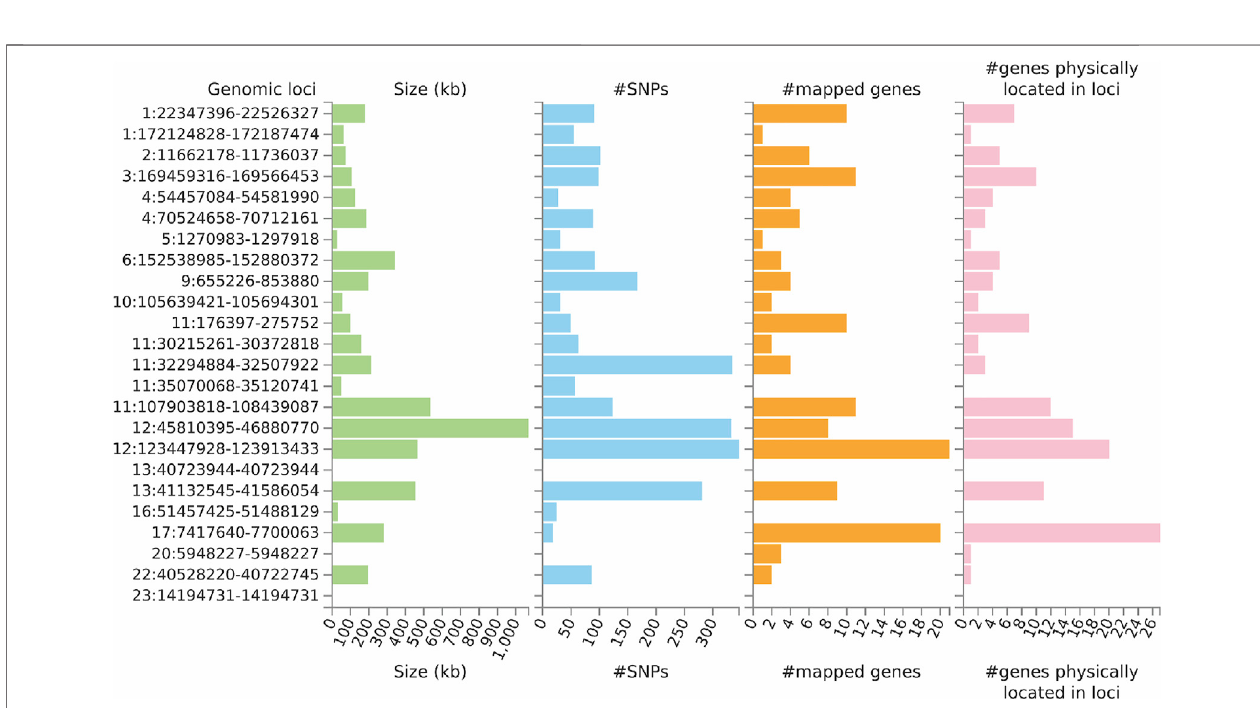
FIGURE4| Geneticrisklociidenti fi edbyFUMAanalysisusingGWASdataonULs.Genomicrisklociaredisplayedintheformatof “ chromosome:startposition--endposition ” on theY axis. For each genomiclocus, histogramsfrom left toright depict the size, the number of candidate SNPs, the number ofmapped genes(using positionalmapping and eQTL mapping), and the number of genes known to be located within the genomic locus, respectively. CAGE, Consortium for the Architecture of Gene Expression; eQTL, expression quantitative trait loci; GWAS, genome--wide association studies; GTEx, Genotype--Tissue Expression; SNP, single nucleotide polymorphism; ULs, uterine leiomyomas.